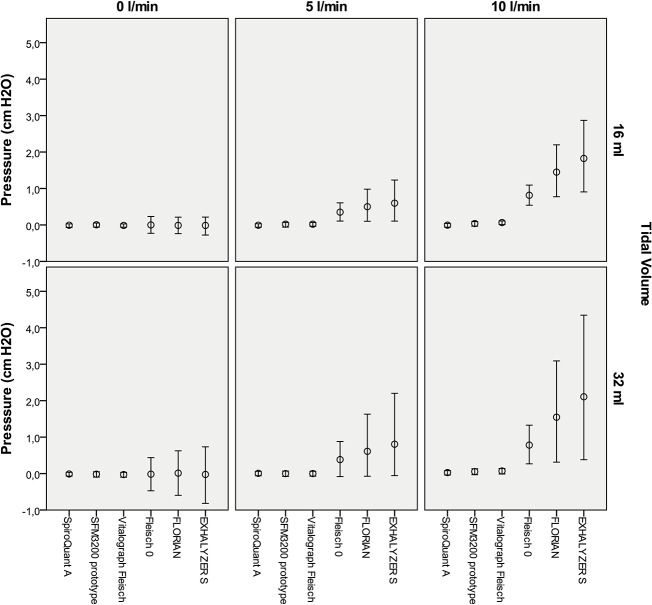
Pressure swings and generated CPAP for three levels of bias flow.A bias flow of 0 L/min is equivalent to in-line placement of flow meter. The circle indicates mean pressure (CPAP) and the bar the mean highest and lowest pressure (the amplitude represent pressure swing) for 20 consecutive breaths. Complete data including variance is available as supplemental information (S1 Table).